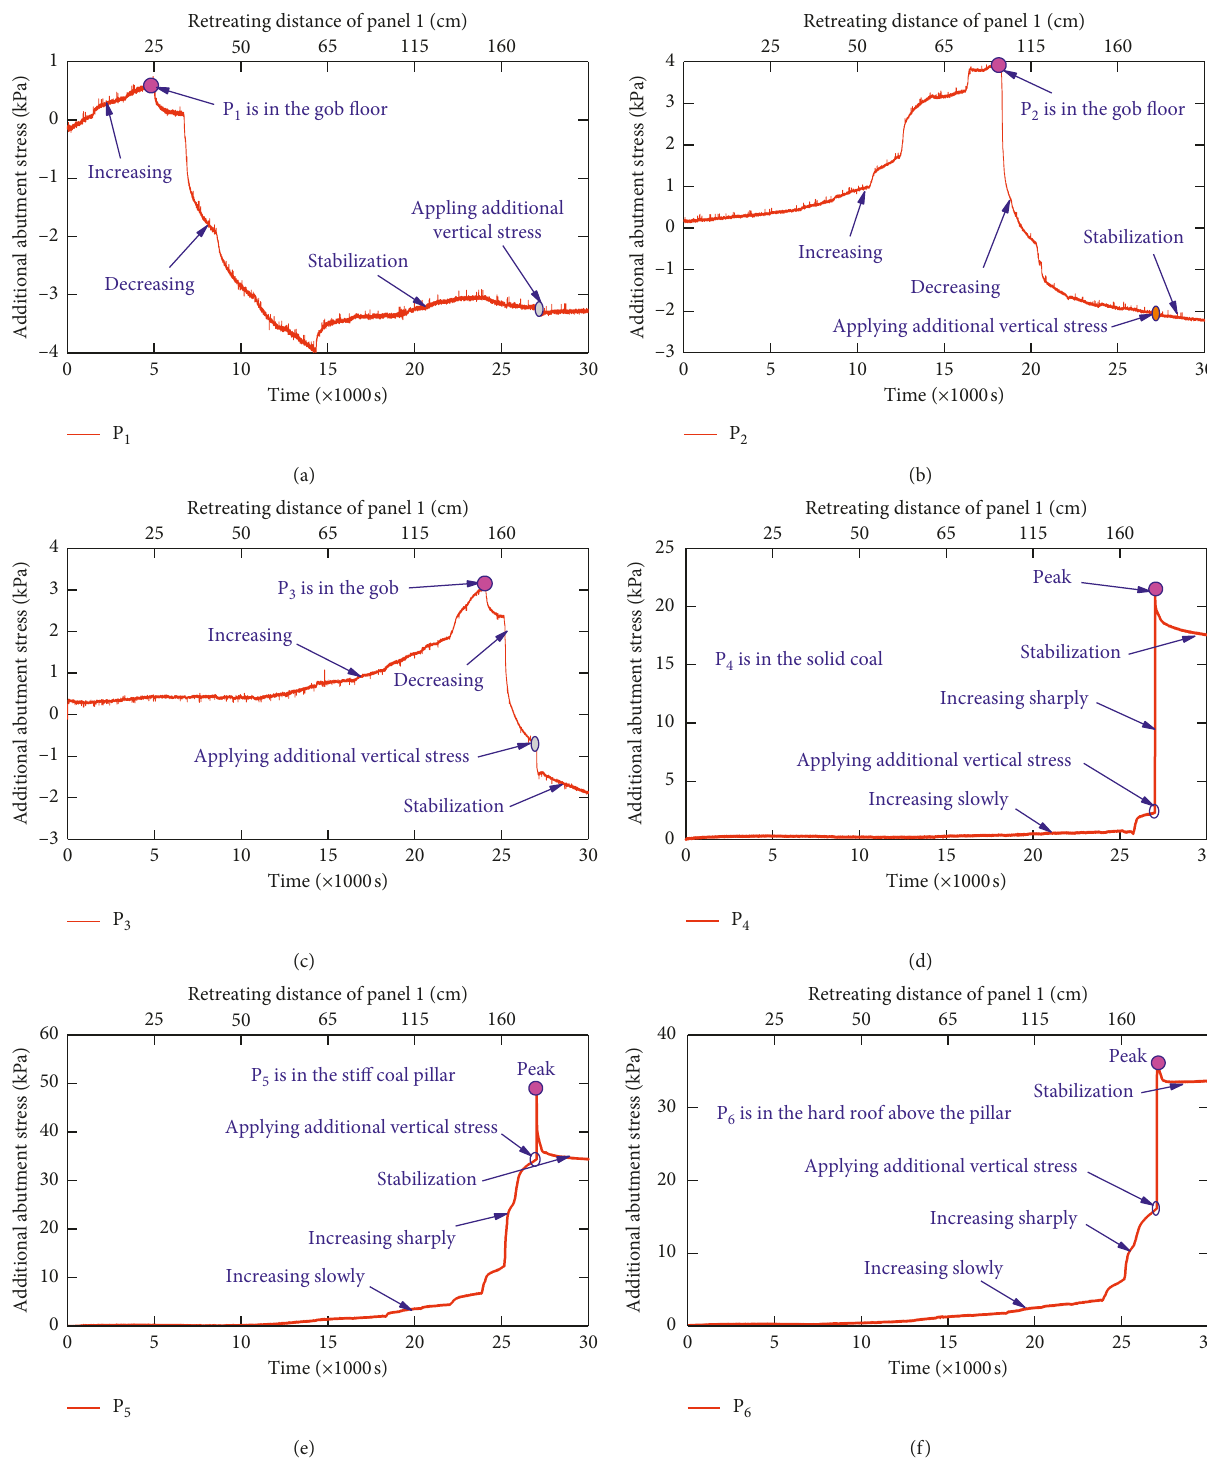
Figure 7: Additional abutment stress evolution during the hard roof activation above the gob. (a) Measuring point of P point of P 2 . (c) Measuring point of P 3 . (d) Measuring point of P 4 . (e) Measuring point of P 5 . (f) Measuring point of P 6